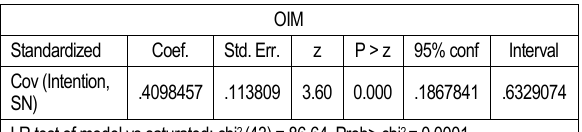
Table 5. Covariance between subjective norm and